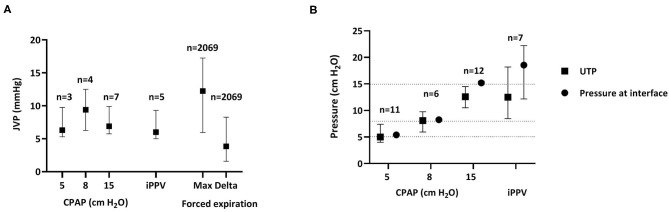
Jugular venous pressure and upper tracheal pressure. (A) Jugular venous pressures [JVP; median (Q1–Q3)] measured during the first 30 min after birth at different CPAP levels and during iPPV as well as the maximum (Max) pressure achieved and the change in pressure (Delta) associated with body movements or forced expirations; n = the number of animals during CPAP or iPPV, whereas n = the number of breaths with active forced expiration. JVPs were compared between groups using Kruskal-Wallis Tests. (B) Pressures [median (Q1–Q3)] measured simultaneously in the upper trachea (UTP, filled squares) and CPAP interface (nasal prongs, filled circles) during CPAP and iPPV throughout the entire experiment (30 + 15 min) n = animal number. Pressures were compared using Wilcoxon Signed-Rank Tests. Dotted horizontal line indicates 5, 8, and 15 cmH2O CPAP.